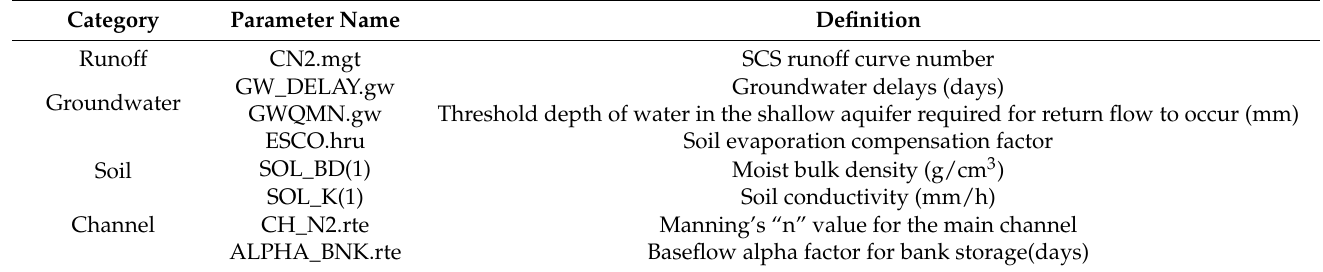
Table 3. Parameters for calibrating the SWAT models with different calibration approaches.